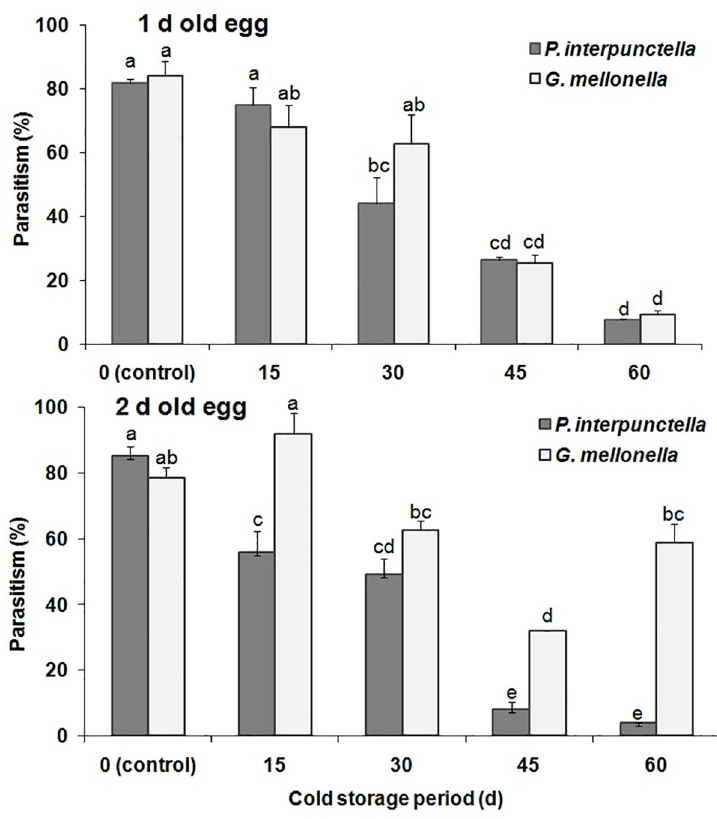
Fig 1. Mean percentage (% ± SE) of parasitism by T . evanescens in P . interpunctella and G . mellonella eggs of different ages on exposed to 4˚C for different intervals (within each egg age and species, bars followed by the same letters are not significantly different; HSD test at